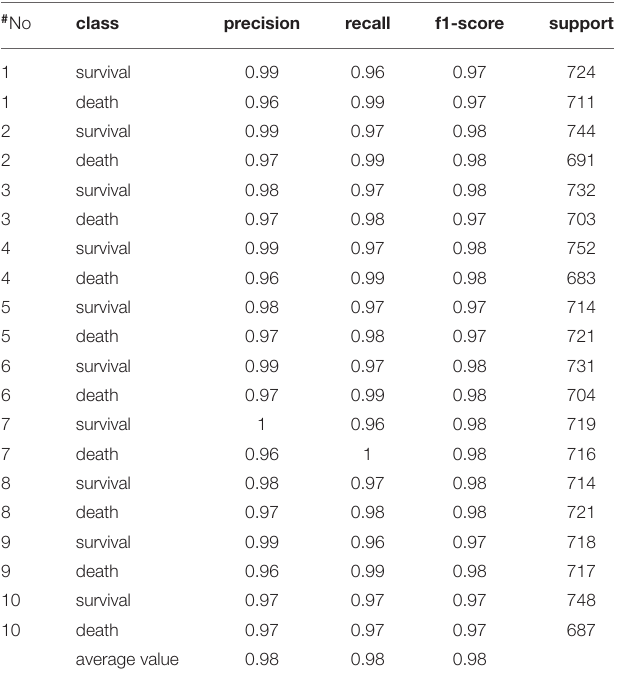
TABLE 3 | The scores of model training based on the features of COVID-19 patients including age, sex, and height in Leishenshan Hospital,